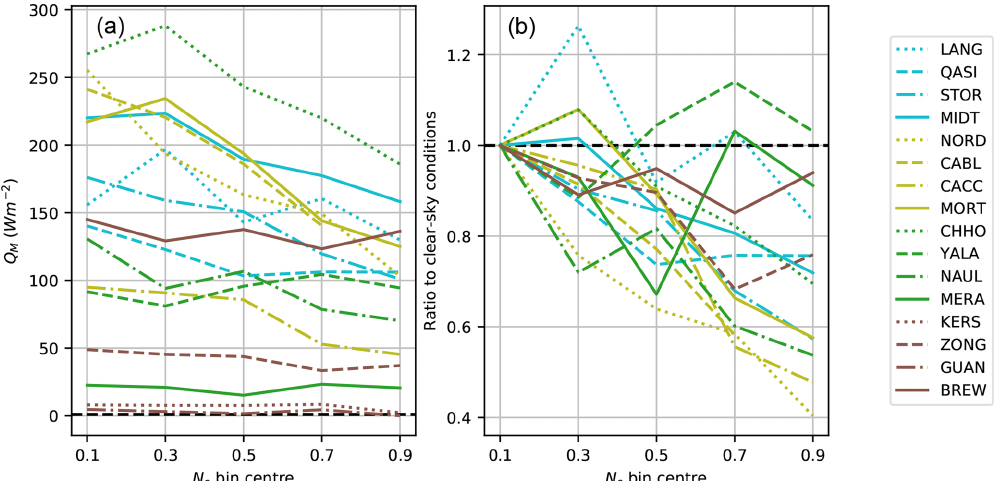
Figure 13. As for Fig. 10 but only for months with > 80% of maximum monthly average Q M . Note GUAN and KERS are excluded from (b) due to insufficient data